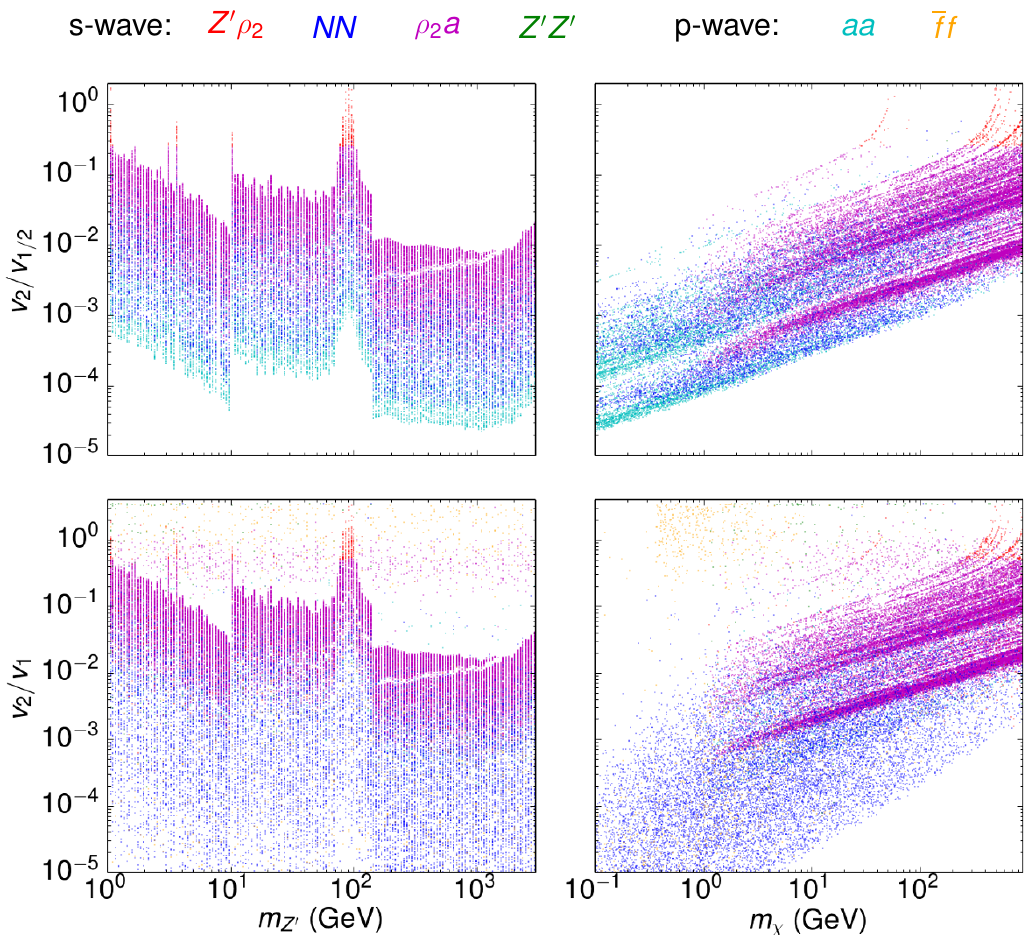
Figure 8 . Viable values of v 2 =v q identi(cid:12)ed for the non-minimal models described in sec- tion 6.1 (top) and section 6.2 (bottom) as a function of the Z 0 mass. The colors